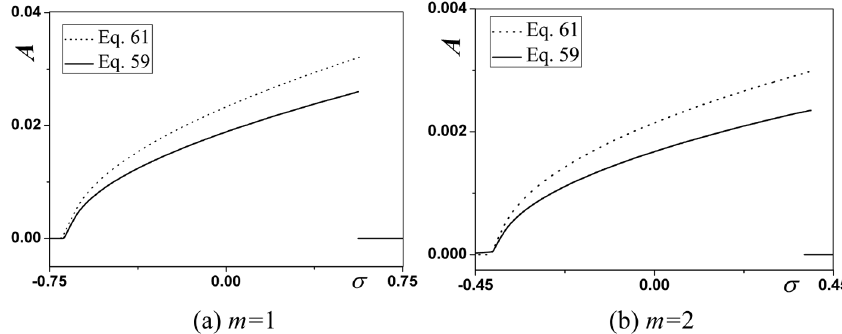
Fig. 14. Comparison of results from Eqs (59) and (61).